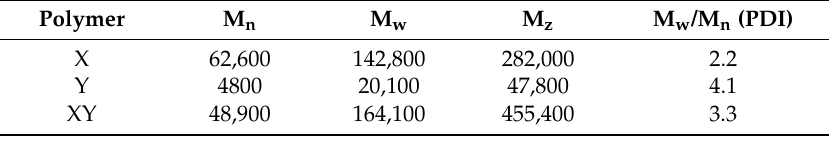
Table 1. GPC analysis of prepared polymers.